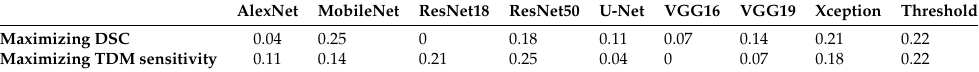
Table 2. Selected weights and thresholds after parameter optimization.